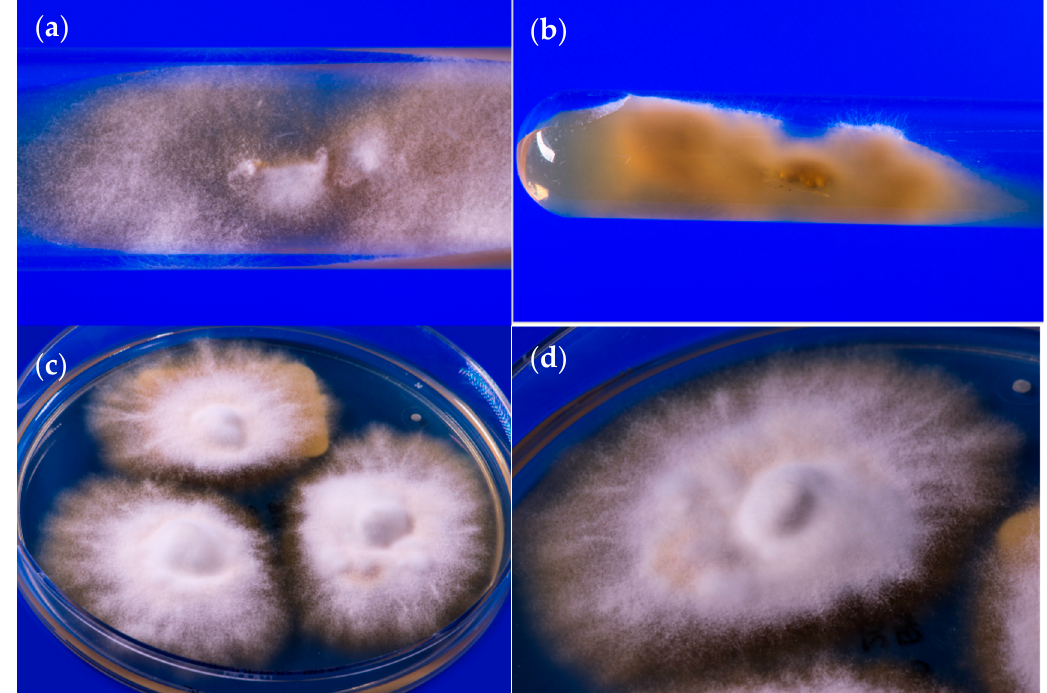
Figure 5. 58-year old male originating from India suffering from tinea faciei due to T . mentagrophytes Type VIII. ( a ) Primary culture on slant agar tubes containing Sabouraud´s dextrose agar. Granular white, flat, fast-growing fungal colonies. ( b ) Yellow to brown stained reverse side of colonies on slant agar tubes. ( c ) Subculture of T . mentagrophytes Type VIII on Sabouraud´s dextrose agar petri dish agar. White, radiating and granular colonies with slightly yellowish stained centre of the colonies. ( d ) Single